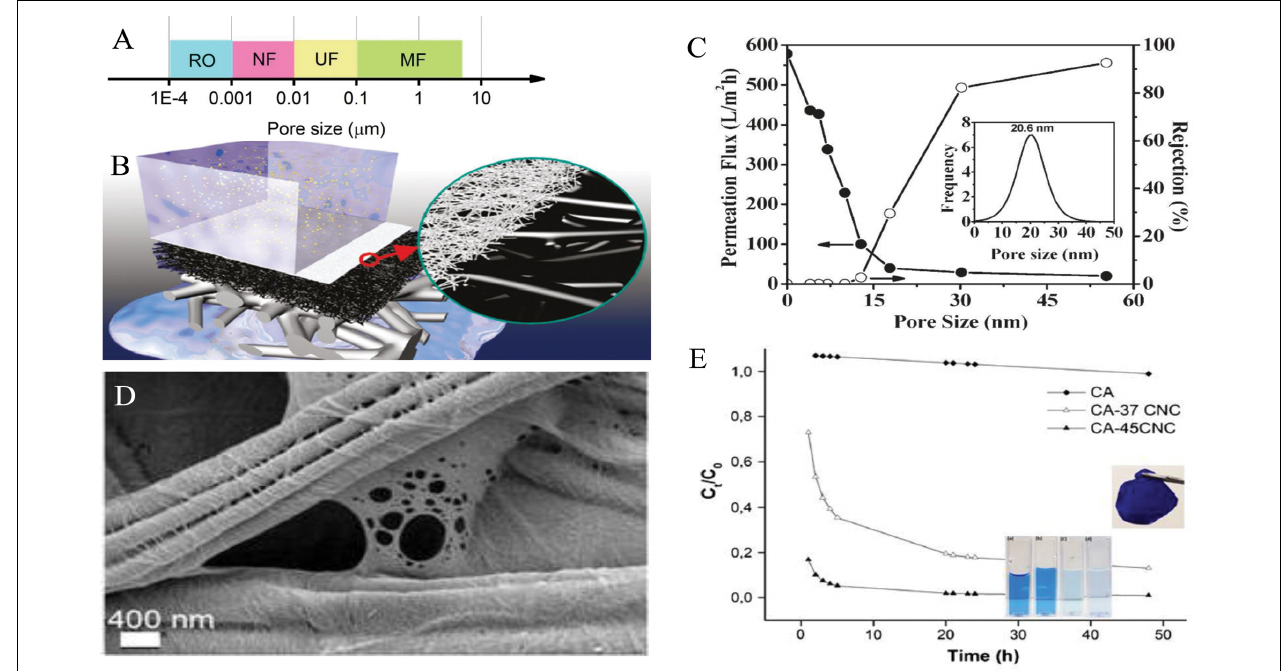
FIGURE 1 | (A) The pore sizes of MF, UF, NF, and RO processes. (B) Schematic illustration of the three-layered fibrous membrane, and (C) its filtration performance (Ma et al., 2011b), reproduced with permission from the American Chemical Society. (D) The SEM image of the electrospun CA nanofibers coated by CNCs, and (E) its filtration performance as a function of CNC content during the time (Goetz et al., 2018), reproduced under the terms of the Creative Commons Attribution (CC BY 3.0) license.